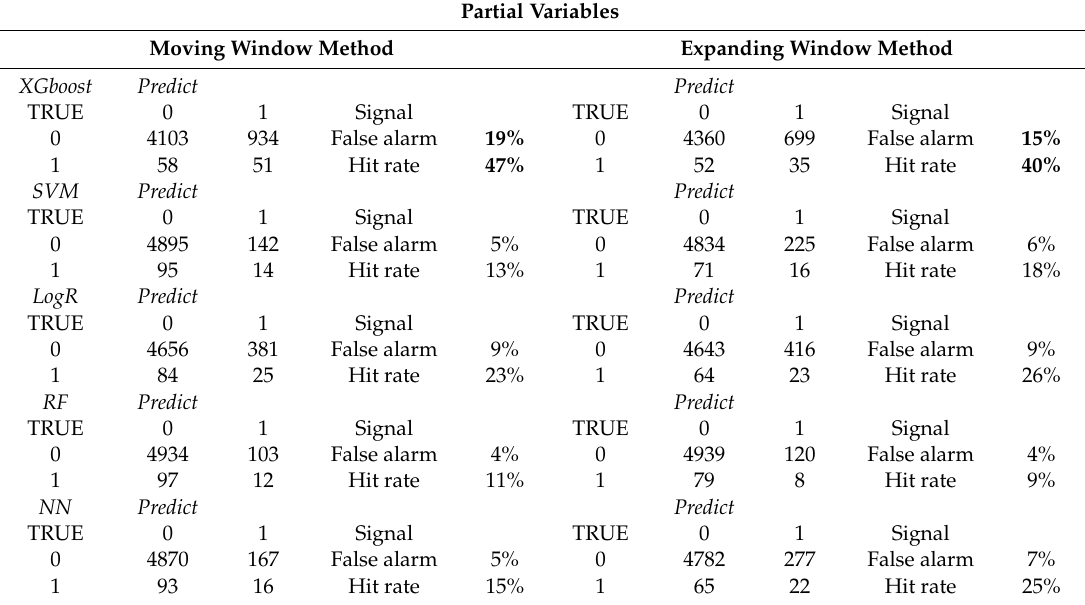
Table 10. Confusion matrix results: Partial variables.